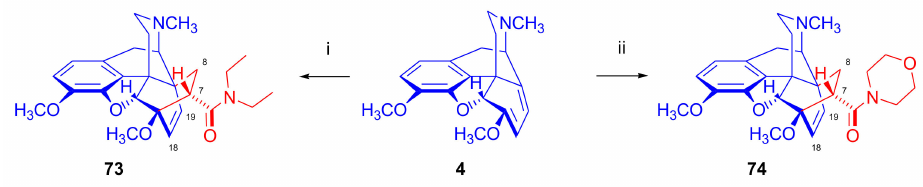
Figure 23. Reaction of thebaine with acrylicacidamides. Reagents and conditions : (i): acrylic acid